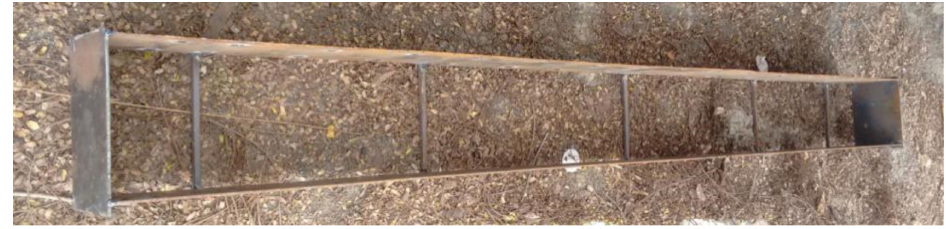
Figure 3. Beam specimen without shear studs.